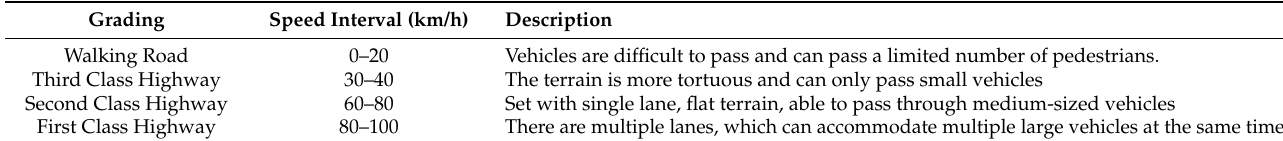
Table 2. Road Classification.